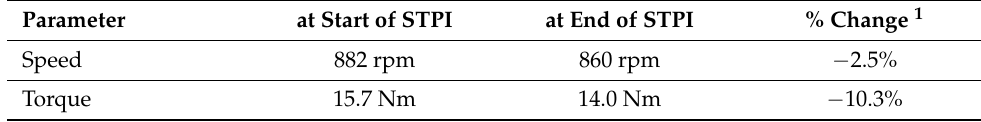
Table 4. Impact on speed and motor torque.